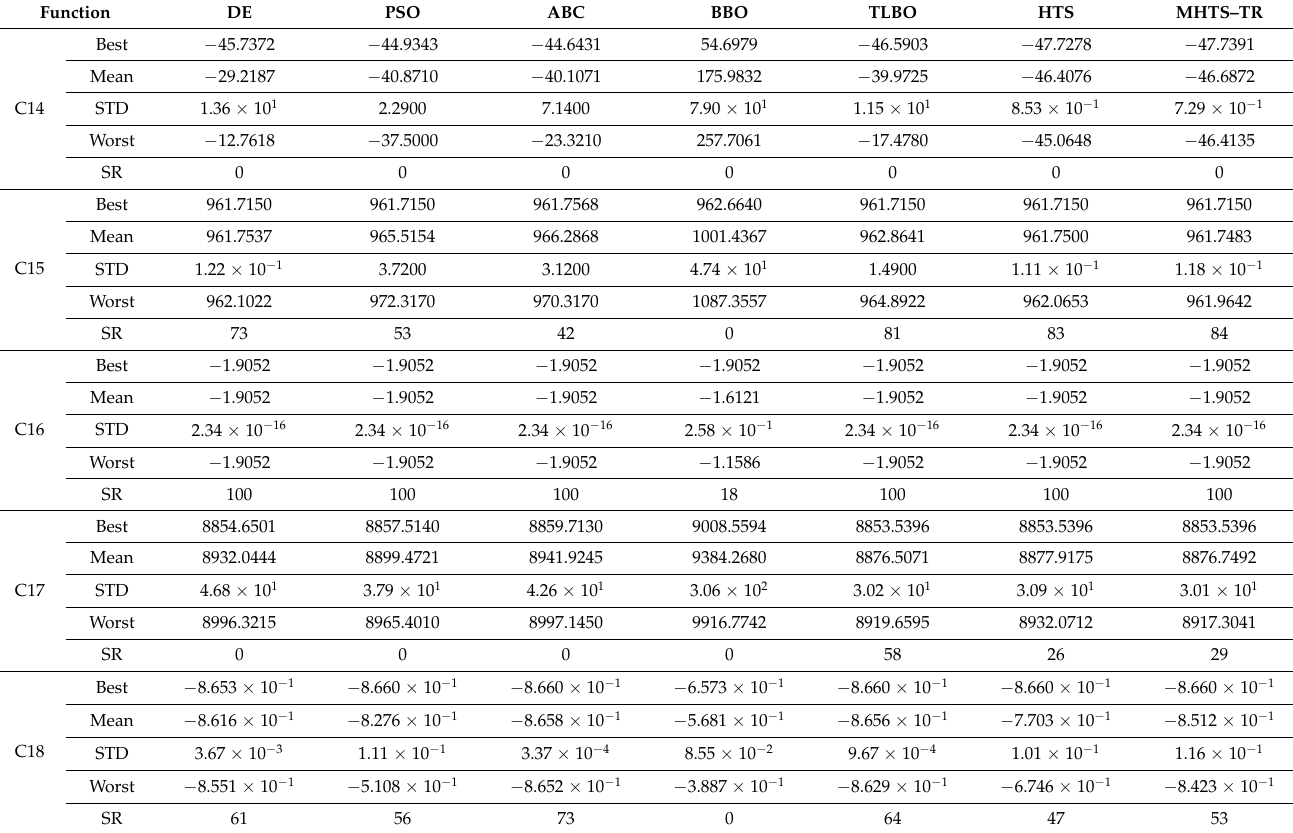
Table 4. Computational results of C14–C24 for the MHTS–TR method with other MHAs. (The experimental results of the competitor algorithms are derived from the literature